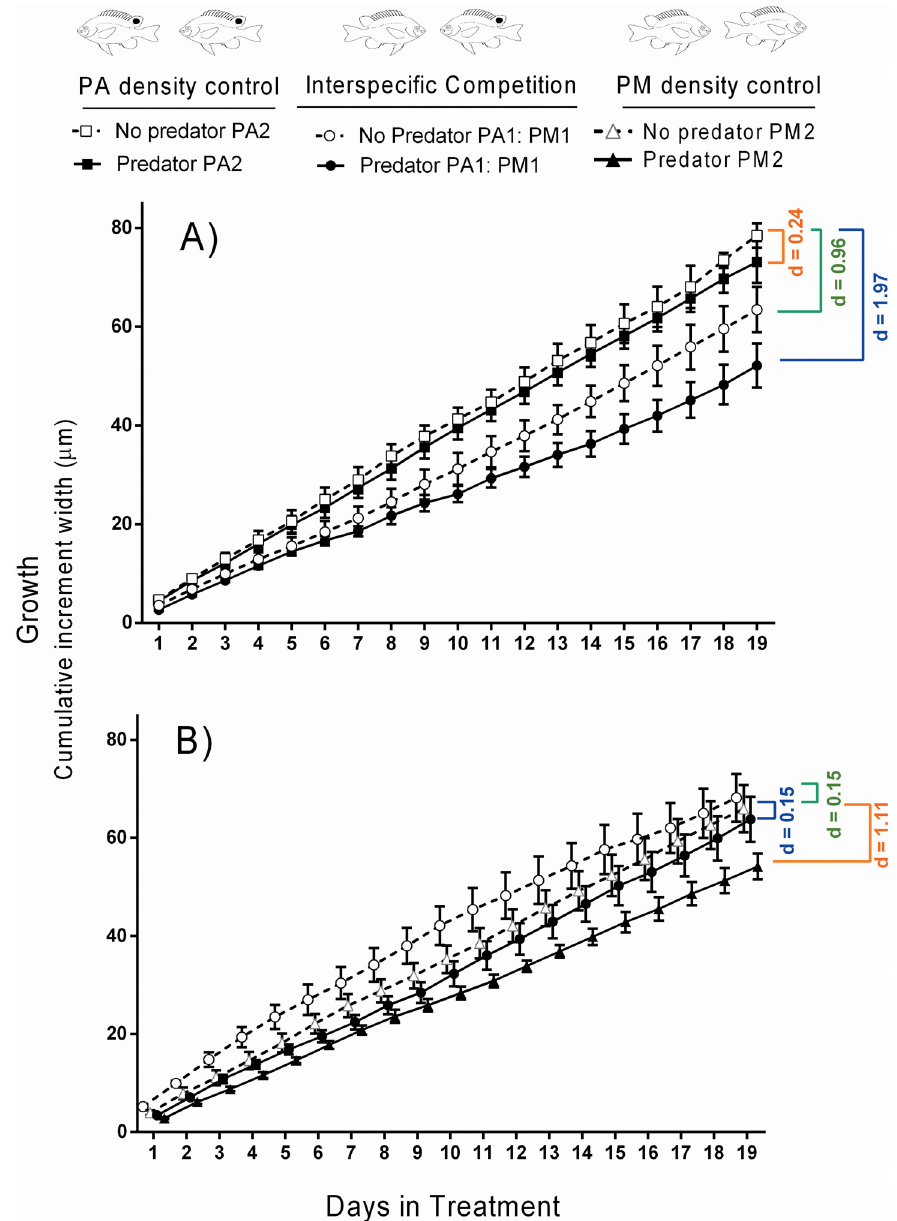
Fig 3. Growth (mean cumulative otolith increment width ± 1 SE) of A) P . amboinensis and B) P . moluccensis during the experimental period according to predator and competitor treatments. Paired conspecific treatments (PA2 and PM2) are controls for the paired heterospecific (interspecific competition) treatment (PA1:PM1). PA = P . amboinensis , PM = P . moluccensis . Colours correspond to effect sizes (Cohen ’ s d values) as follows: orange = predator effects only, green = competitor effects only, blue = both predator and competitor effects. Effect sizes were calculated from day 19 cumulative growth data. competition and predation (d = 1.97) were greater than the additive effects of predation and competition alone (0.24+0.96 = 1.20), indicating a synergistic effect of competition and preda- tion for P . amboinensis (Fig 3A). These effects increased over time, and growth trajectories between predator treatments in the interspecific competition treatment became more disparate